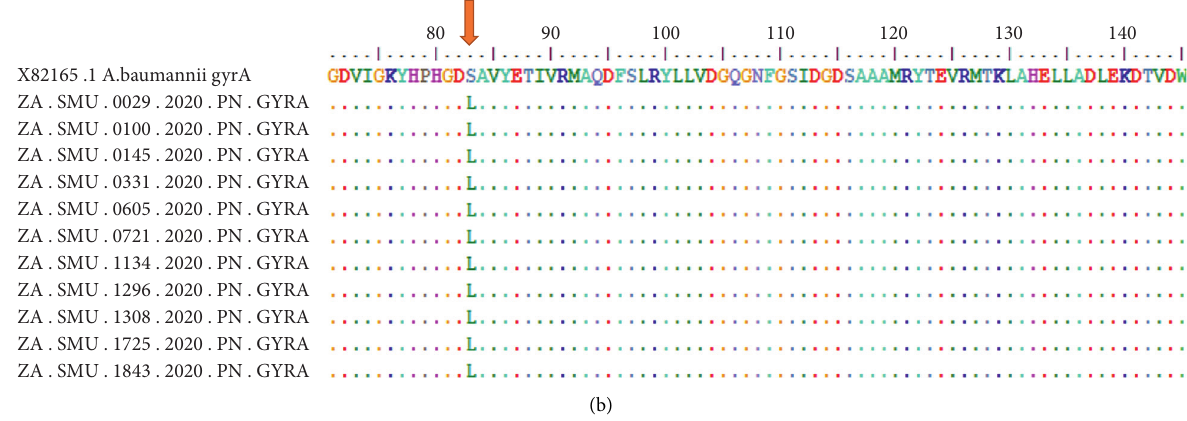
Figure 3: Sequences analysis of gyrA gene.